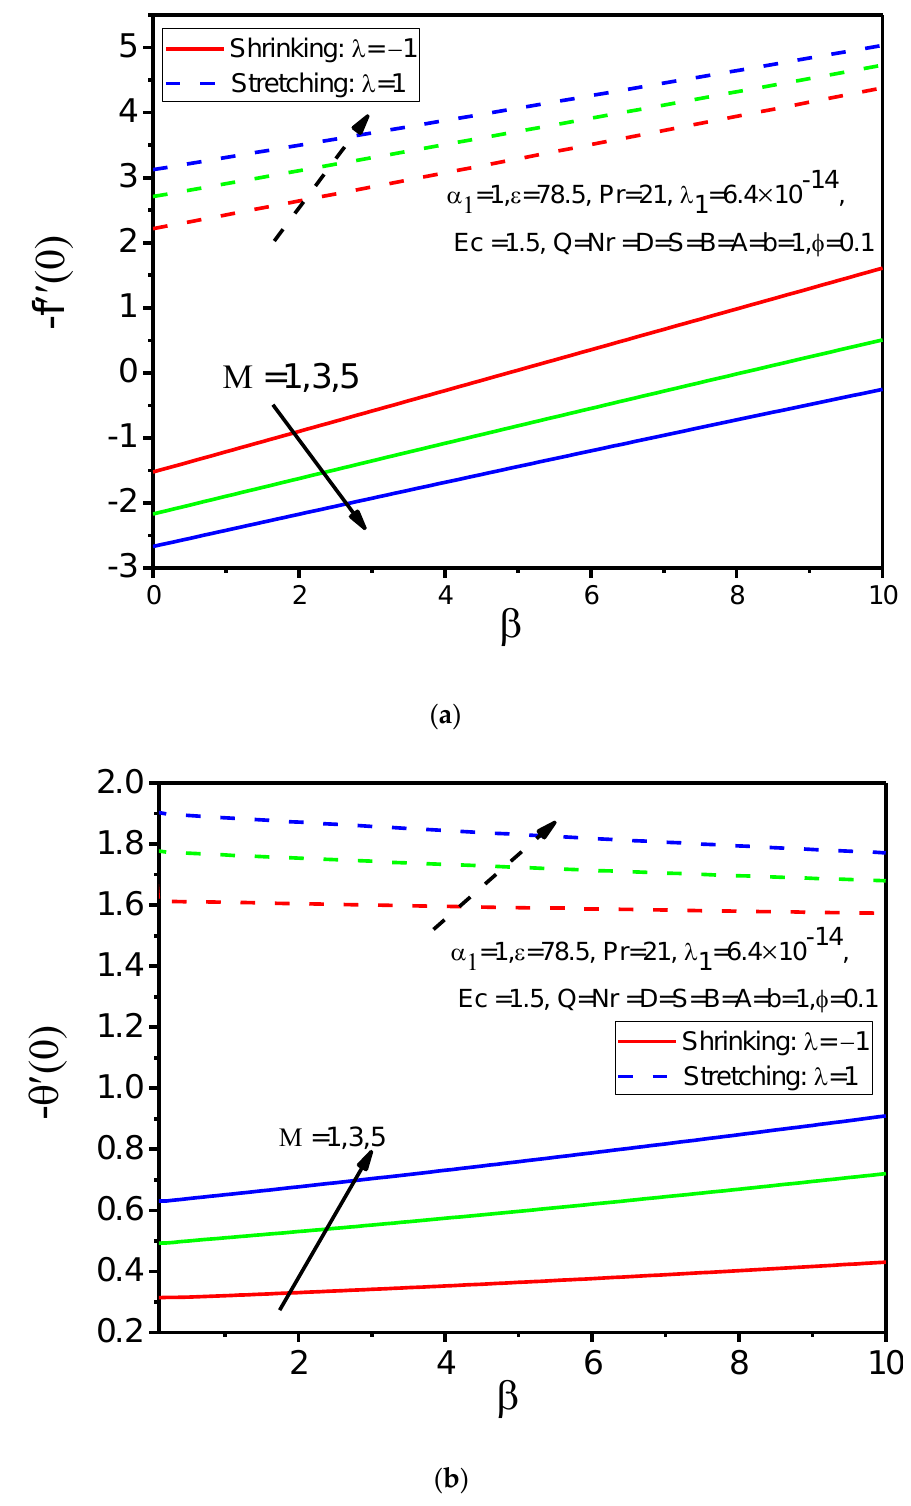
M Figure 15. Influence of against  on ( a ) Skin friction coefficient, ( b ) Rate of heat transfer. Figure 15. Influence of M against β on ( a ) Skin friction coefficient, ( b ) Rate of heat